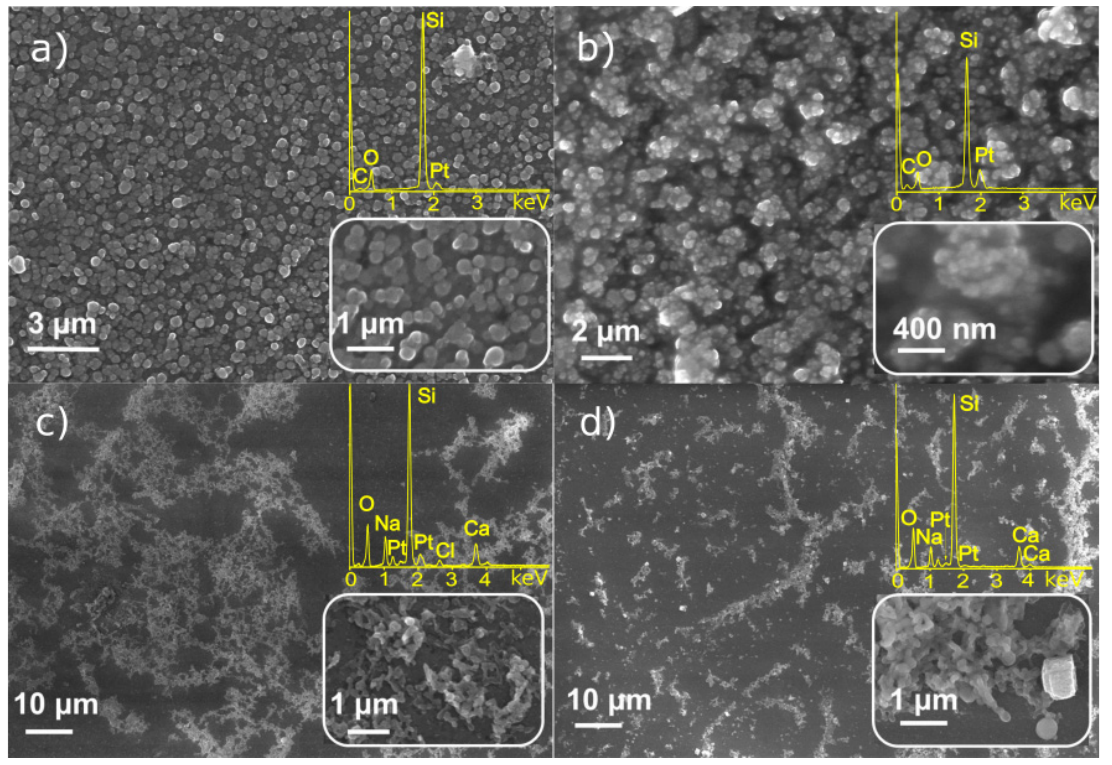
Figure 3. SEM/EDX analysis of particles synthesized from ( a ) C 8 H 18 OPtSi 2 in vinyl terminated polydimethylsiloxane (0.1 M), ( b ) C 8 H 18 OPtSi 2 in hexane C 6 H 14 (3.9 mM), ( c ) (C 8 H 12 )Cl 2 Pt in dichloromethane CH 2 Cl 2 (5.3 mM), ( d ) (C 8 H 12 )Cl 2 Pt in dichlorethane C 2 H 4 Cl 2 (1.3 mM).